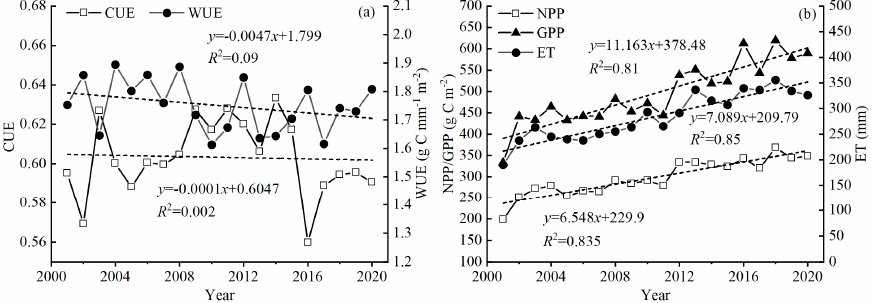
Figure 2. Variation in ( a ) CUE and WUE from 2000 to 2020 in the Loess Plateau. ( b ) NPP , GPP and ET from 2000 to 2020 in the Loess Plateau.